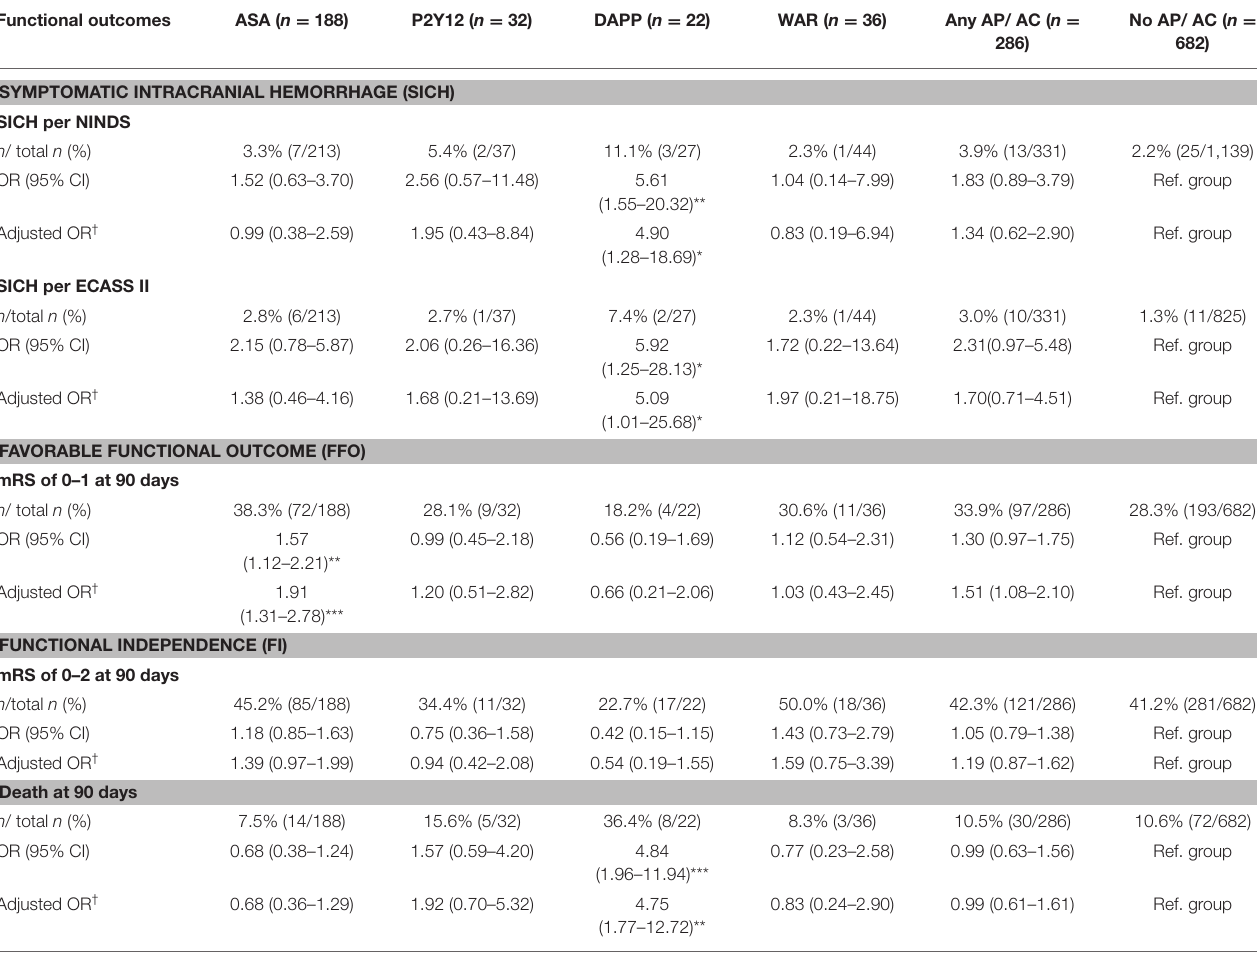
TABLE 2 | Functional Outcome at 3 months